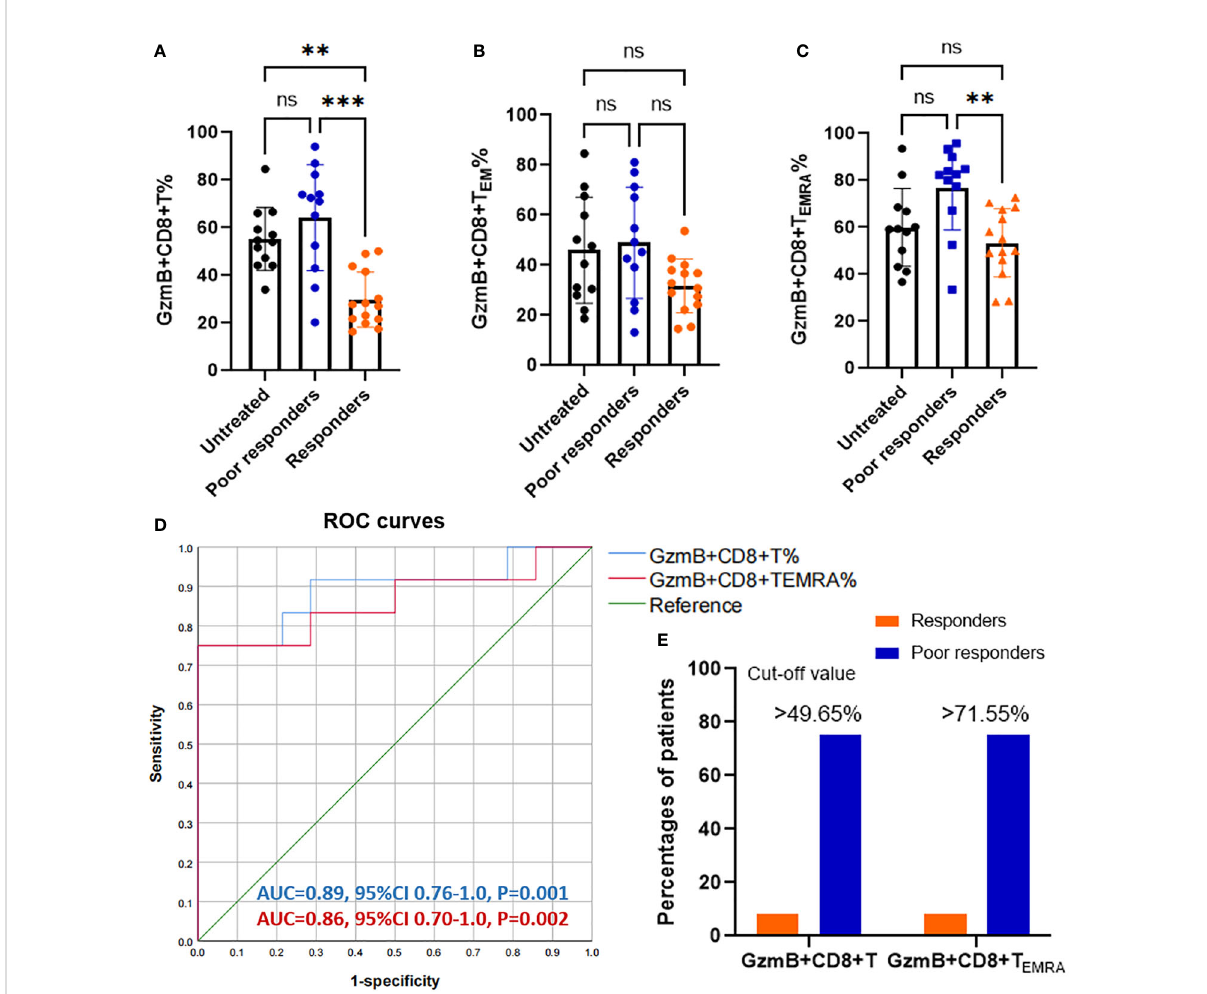
FIGURE 2 Increasing proportions of GzmB-expressing CD8+ T cells in poor responders with NMOSD. (A – C) Patients with neuromyelitis optica spectrum disorder (NMOSD) were divided into three groups according to the response to immunotherapies, including untreated (NT) patients (n=12), responders (n=14), and poor responders (n=12). Poor responders exhibited a signi fi cant increase in GzmB+CD8+ T% (A) and GzmB+CD8+ T EMRA % (C) , but not in GzmB+CD8+ T EM % (B) . (D) Receiver operating characteristic (ROC) curve for evaluating the diagnostic sensitivity and speci fi city of GzmB-expressing CD8+ T cells in responders and poor responders. Diagnostic accuracy was assessed based on the area under the curve (AUC). (E) Percentages of patients with levels of GzmB-expressing CD8+ T cells over the cut-off value in responders and poor responders. GzmB: granzyme B **P<0.01, ***P<0.001, and ns (not signi fi cant) by Kruskal-Wallis test with Dunn ’ s multiple comparisons